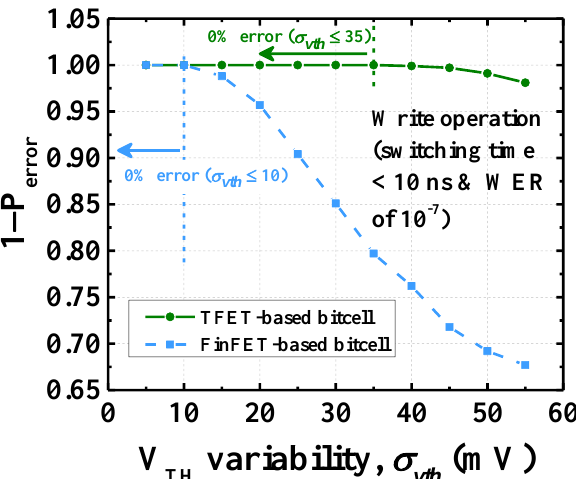
Figure 7. Yield of write operation for the fast switching regime ( < 10ns) expressed in terms of error probability (P error ) ) as function of the threshold voltage variability ( σ vth ) of TFET and FinFET devices. Each point is the result of Monte Carlo simulation with 1000